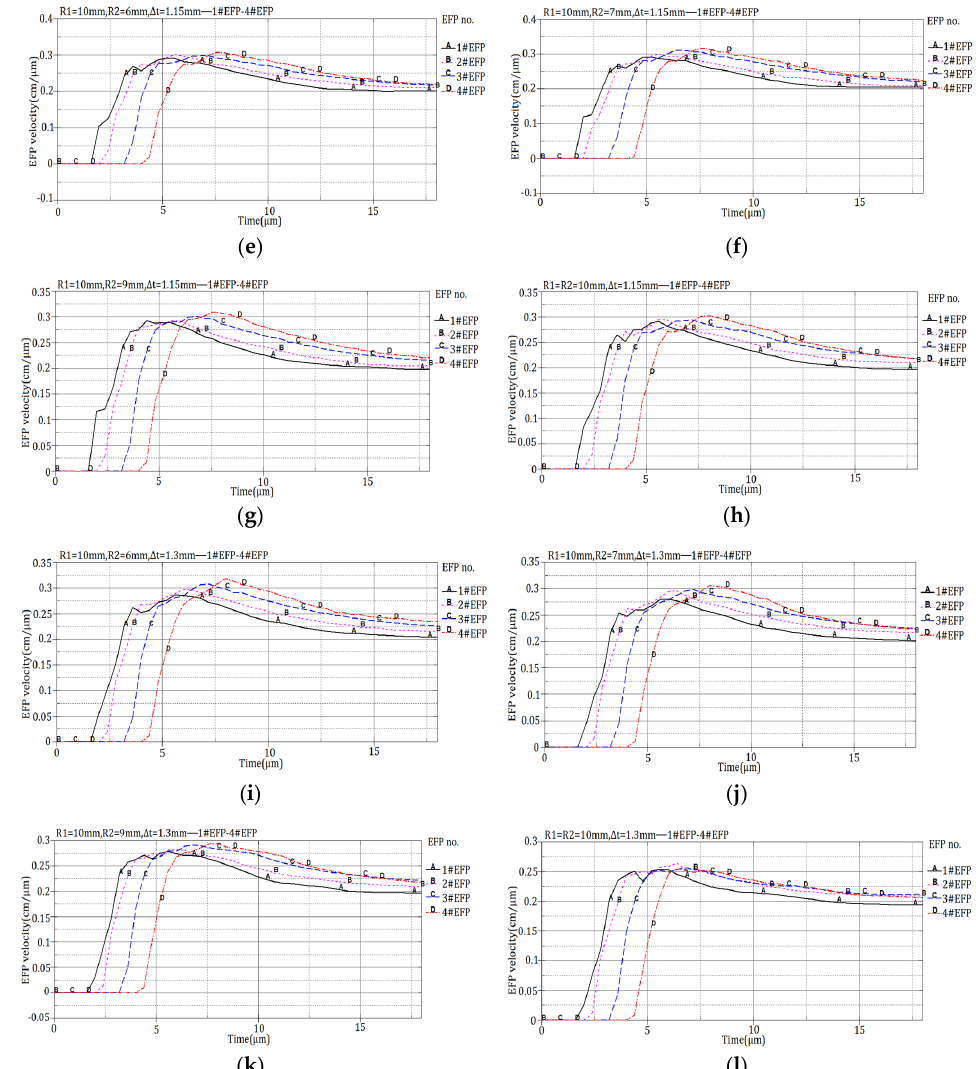
Figure 9. 1#EFP-4#EFP formed velocity of the liner which different curvature radius of outer wall and different center thickness:( a ) R1 = 10 mm, R2 = 6 mm, ∆ t = 1.0 mm; ( b ) R1 = 10 mm, R2 = 7 mm, ∆ t = 1.0 mm; ( c ) R1 = 10 mm, R2 = 9 mm, ∆ t = 1.0 mm; ( d ) R1 = R2 = 10 mm, ∆ t = 1.0 mm;